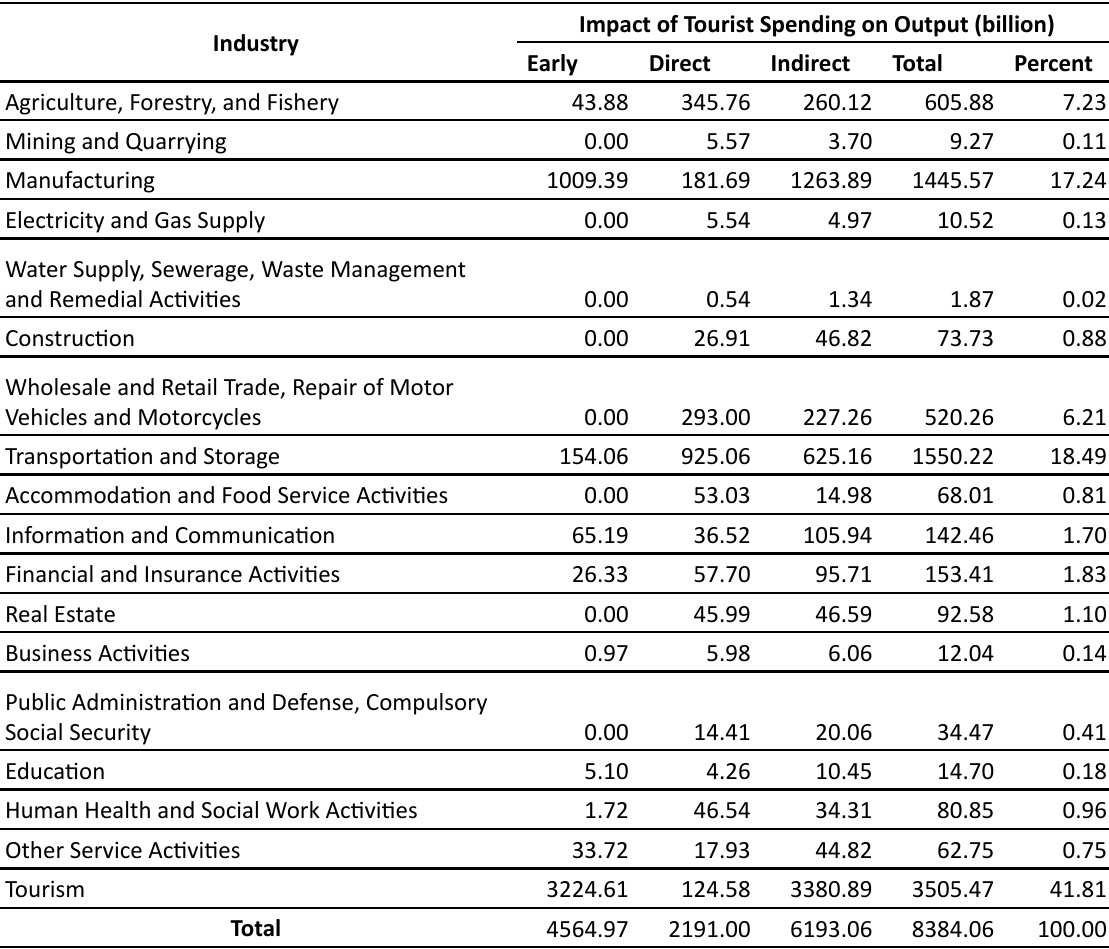
Table 7: Impact of Tourist Expenditure on Output North Sulawesi Province in 2018 Impact of Tourist Spending on Output (billion) Industry Early Direct Agriculture, Forestry, and